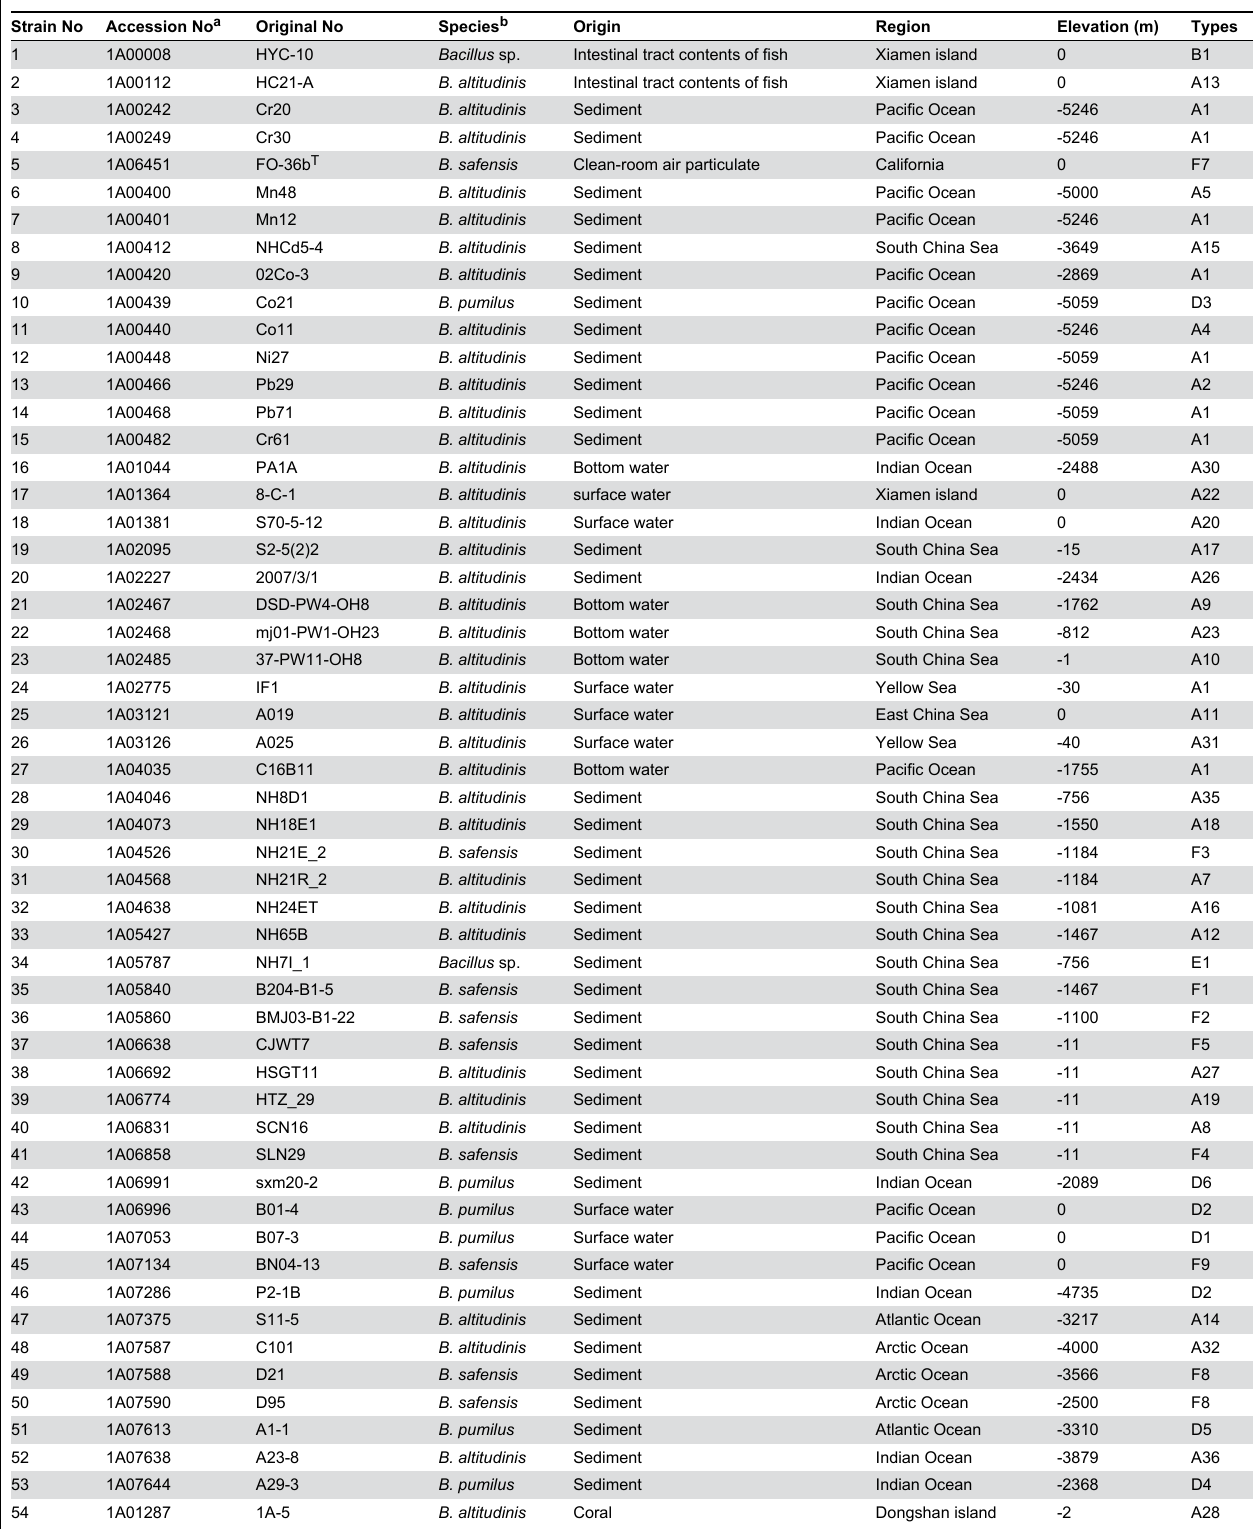
Table 1. Bacterial isolates of the B. pumilus group strains used in MLSA